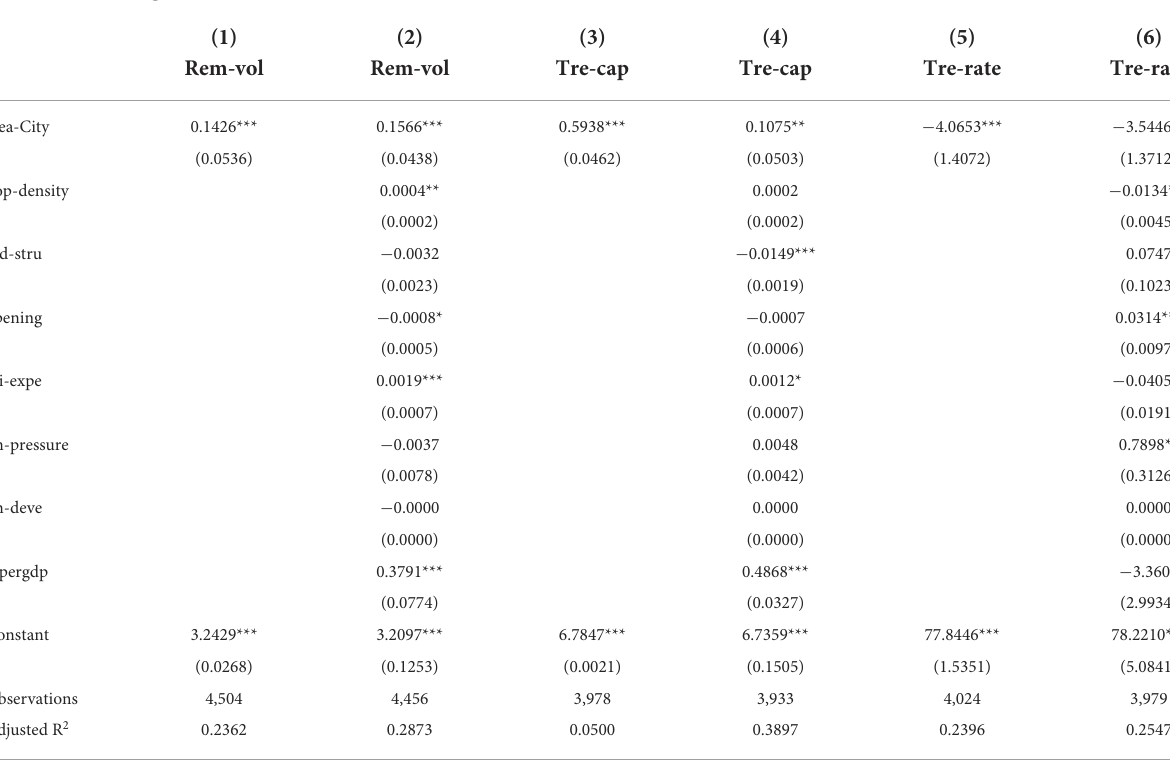
TABLE 2 Baseline regression.